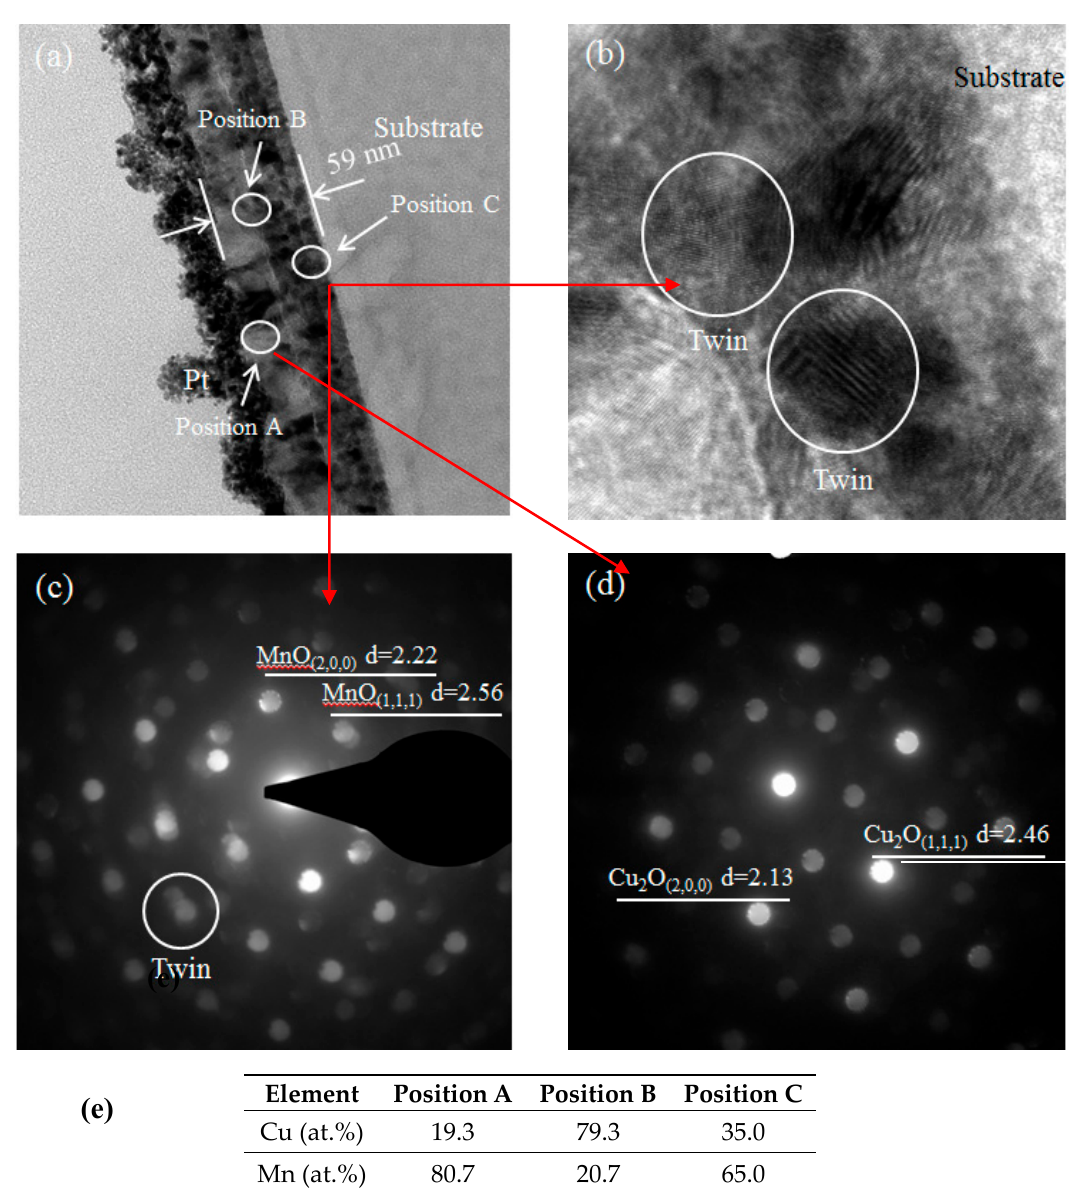
Figure 2. TEM micrographs of Cu–Mn films annealed at 300 ° C: ( a ) bright field of cross section; ( b ) HRTEM micrographs; ( c ) selected-area electron diffraction at position C; ( d ) selected-area electron diffraction at position A; ( e ) Energy Dispersive X-ray Analysis EDX analysis.